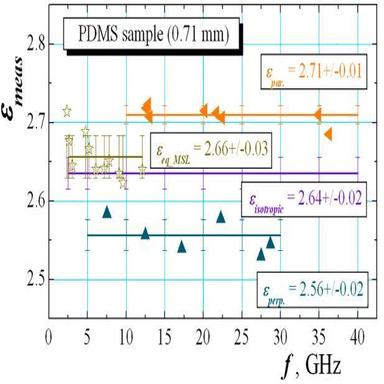
Measured parallel and perpendicular dielectric constants of PDMS substrate with thickness 0.71 mm by the two-resonator method compared with the equivalent dielectric constant from the planar measurements.